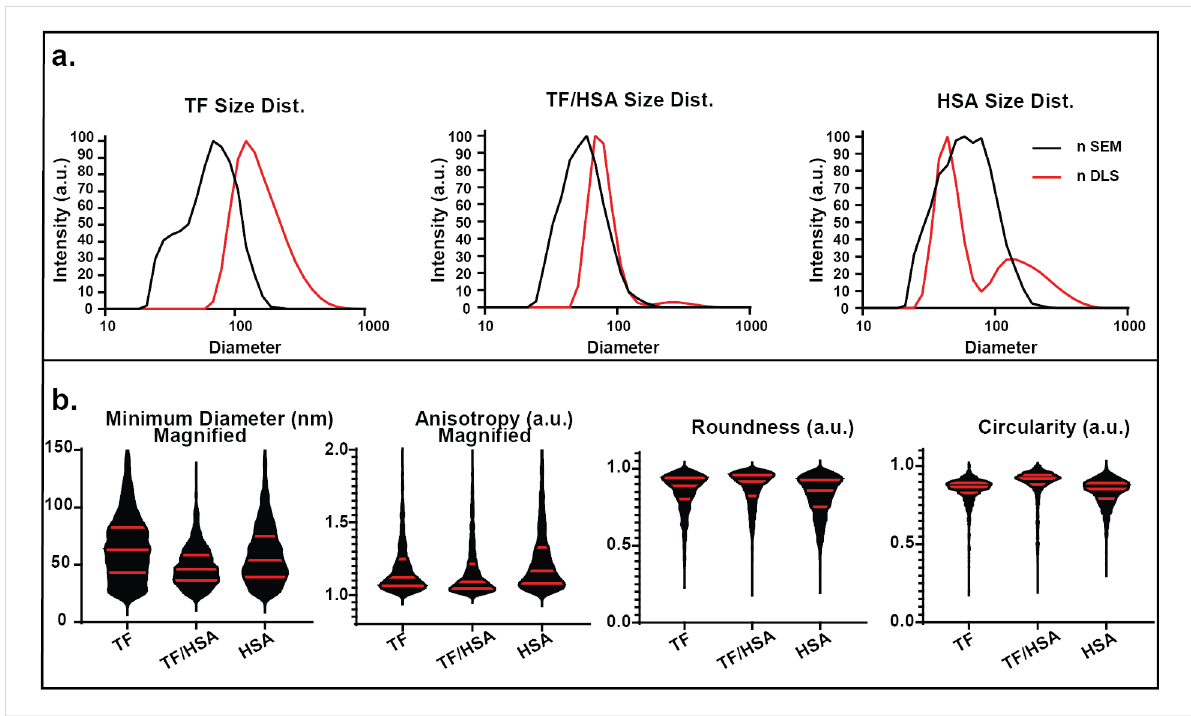
Figure 3: Size distribution and secondary geometric factors of TF SPNPs based on SEM and DLS analysis. (a) Number distributions of SPNP sizes as obtained by SEM and DLS. (b) Violin graphs of minimum diameter, anisotropy, circularity and roundness (median and interquartile ranges are presented by red